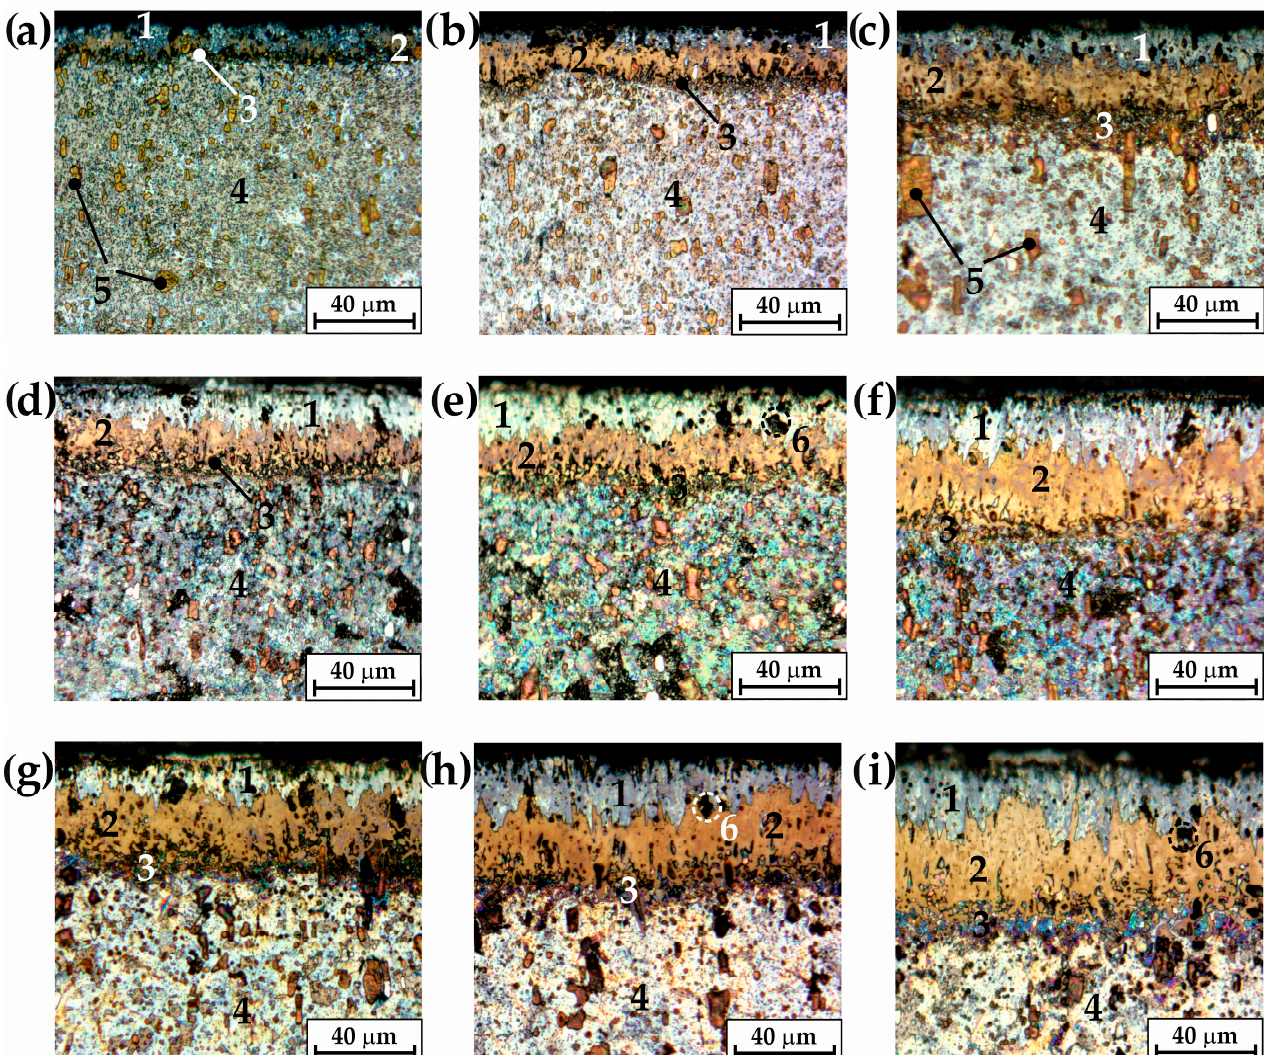
Figure 6. Microstructure of X165CrV12 tool steel after powder-pack boriding using various param- eters: ( a ) 1123 K for 3 h, ( b ) 1123 K for 6 h, ( c ) 1123 K for 9 h, ( d ) 1173 K for 3 h, ( e ) 1173 K for 6 h, ( f ) 1173 K for 9 h, ( g ) 1223 K for 3 h, ( h ) 1223 K for 6 h, ( i ) 1223 K for 9 h; 1—FeB zone, 2—Fe 2 B